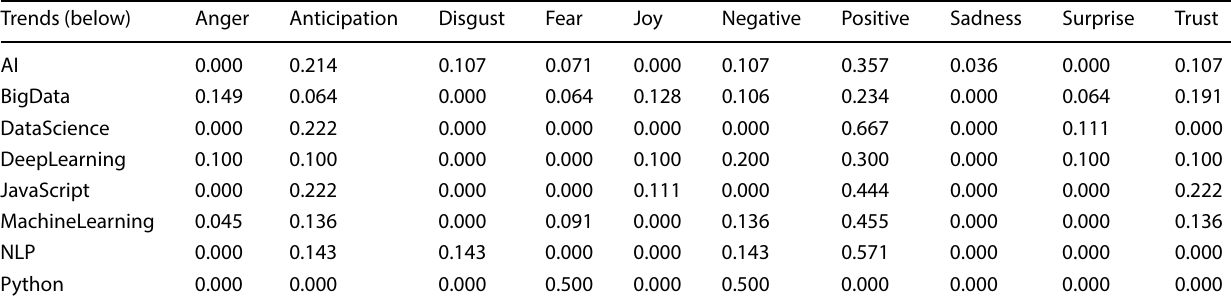
Table 2 Trending IoT tweet topics having the highest probability of positive sentiment are highlighted in this conditional probability table Trends